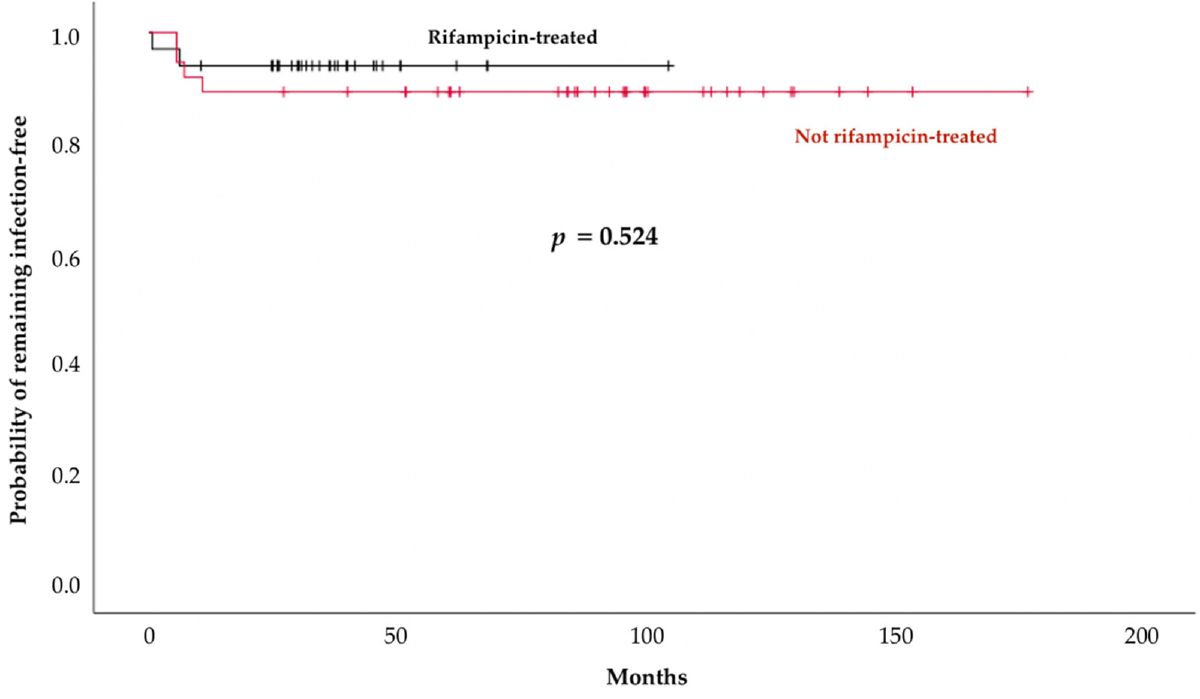
Figure 2. Kaplan–Meier estimated reinfection (relapse or new infection)-free probabilities for the 37 rifampicin recipients and the 33 patients treated without it for chronic Ca-PJIs.